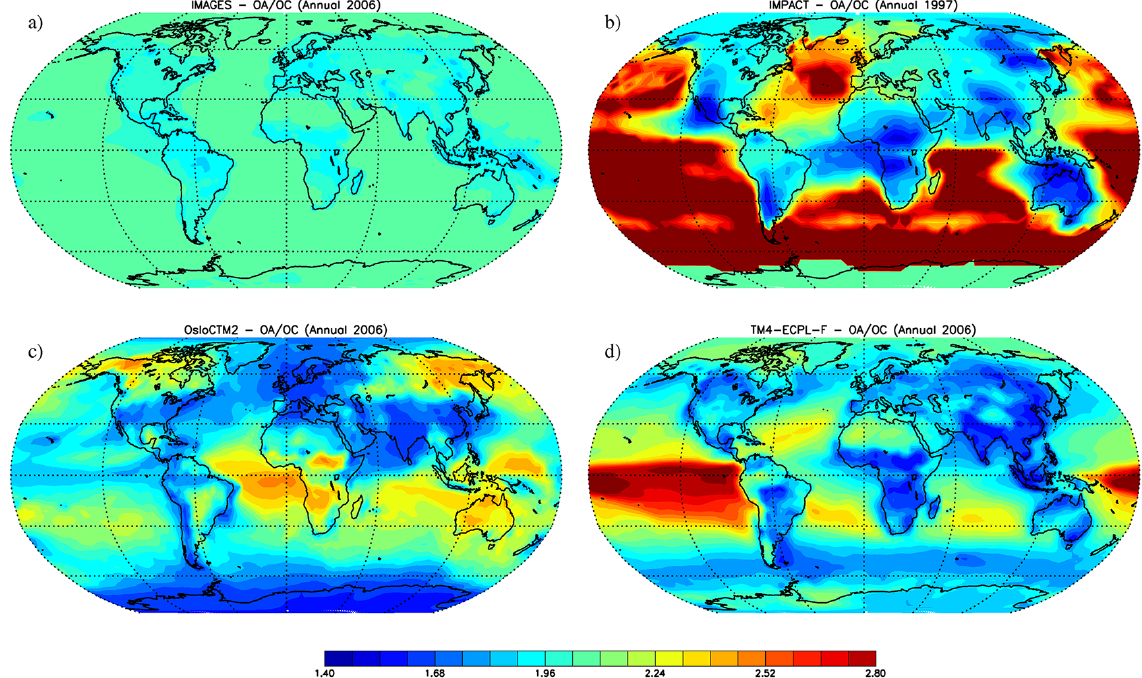
Figure 15. Annual mean OA/OC at surface as calculated by IMAGES (a) , IMPACT (b) , OsloCTM2 (c) and TM4-ECPL-F (d)